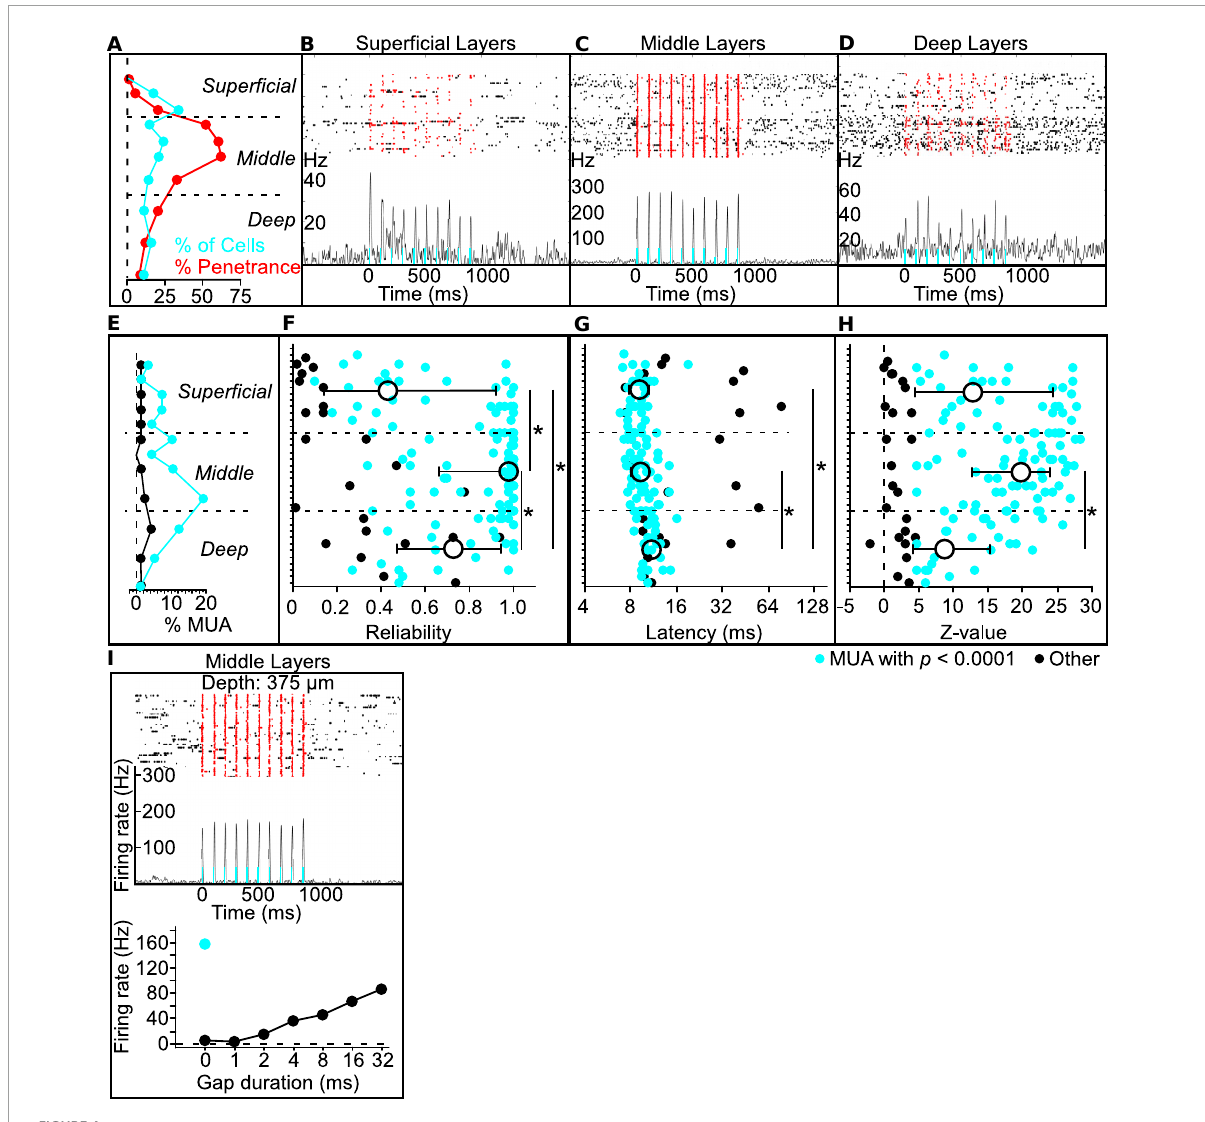
FIGURE4 Putative Gpr26 neurons exhibit gap termination responses (GTRs). (A) The percentage of total cells recorded per sublayer that were found to be photoresponsive (in blue) was far lower than expected based on the penetrance of the line as determined in GPR26-tdTomato mice (in red, same as Figure 1C ). However, when applied to multi-unit activity (MUA), the same analyses yielded results consistent with the Gpr26 expression pattern. (B–D) Example multi-unit recordings from a single silicon probe penetration (approximate depths B: 175 µ m, C: 475 µ m, D: 875 µ m). The raster (top) displays spikes before, during, and after each pulse train presentation. Red dots indicate spikes captured during presentations of each 5 ms light pulse of each train. Trial-averaged firing rate is shown below the raster plots; note the different vertical scales for firing rate. (E) Using a conservative significance threshold for MUA ( p < 0.0001; see section “Materials and methods”), a higher proportion of all photoresponsive “tetrodes” (see section “Materials and methods”) recorded was found in middle layers 3b-5a compared with superficial and deep layers (layers 1a-3a and layers 5b-6b, respectively). MUA analyses in E-H included significantly responsive (blue) and non-responsive (black) tetrodes . (F) Median reliability in middle layers exceeded that observed in superficial and deep layers. Reliability in the superficial layers was also lower than that in the deep layers. (G) Median peak response latency in both middle and superficial layers was faster than that observed in deep layers. (H) Signal-to-noise ( z -values) in middle layers was greater than that observed in deep layers, with a trend toward more robust responses versus superficial layers. (I) Activity of an example middle-layer putative Gpr26 neuron, including a robust phase-locked response to the pulse train (top panel), GTRs evoked by multiple gap durations (bottom panel, black dots), and a robust increase in spiking with illumination during gap-free trials (bottom panel, blue dot). Boxes show median and IQR. * p < 0.05, rank-sum.